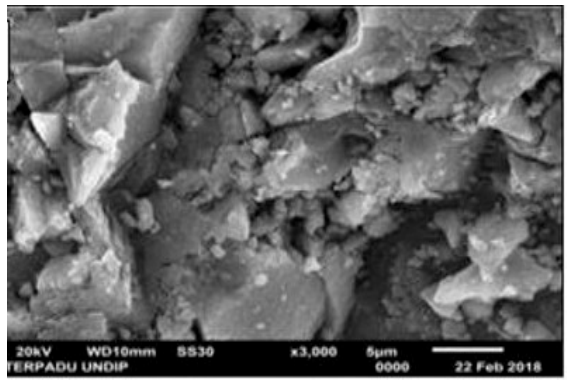
Figure 3. Scanning Electron Microscopy (SEM) image of magnetite nanoparticles synthesized by co- precipitation method (adapted from [41] with permission from IOP Publishing). co-precipitation method (adapted from [41] with permission from IOP